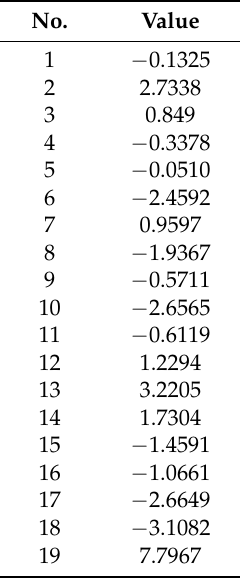
Table 3. The weight